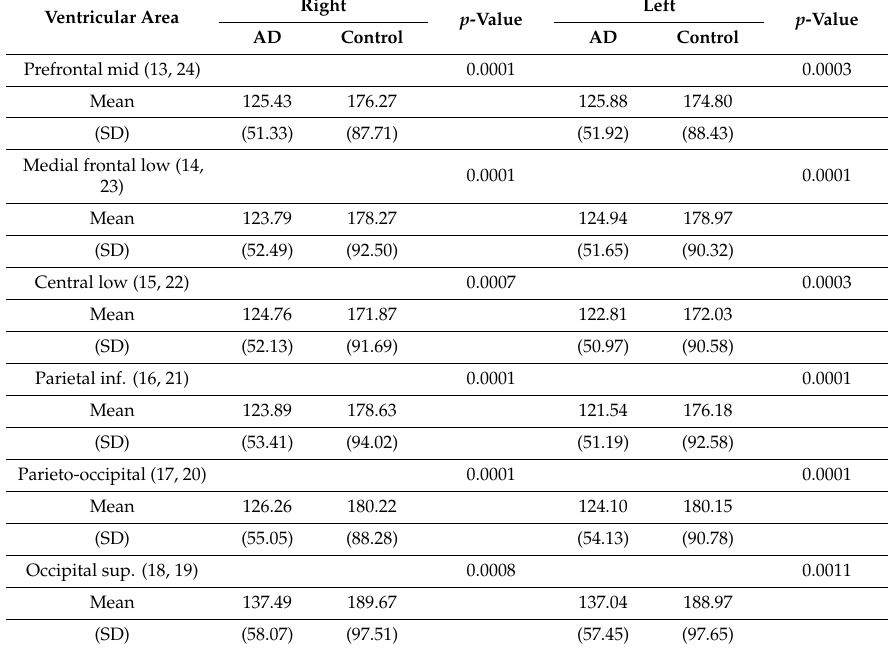
Table 2. Comparison count number ventricular area of the brain for AD patients and control group (mean and